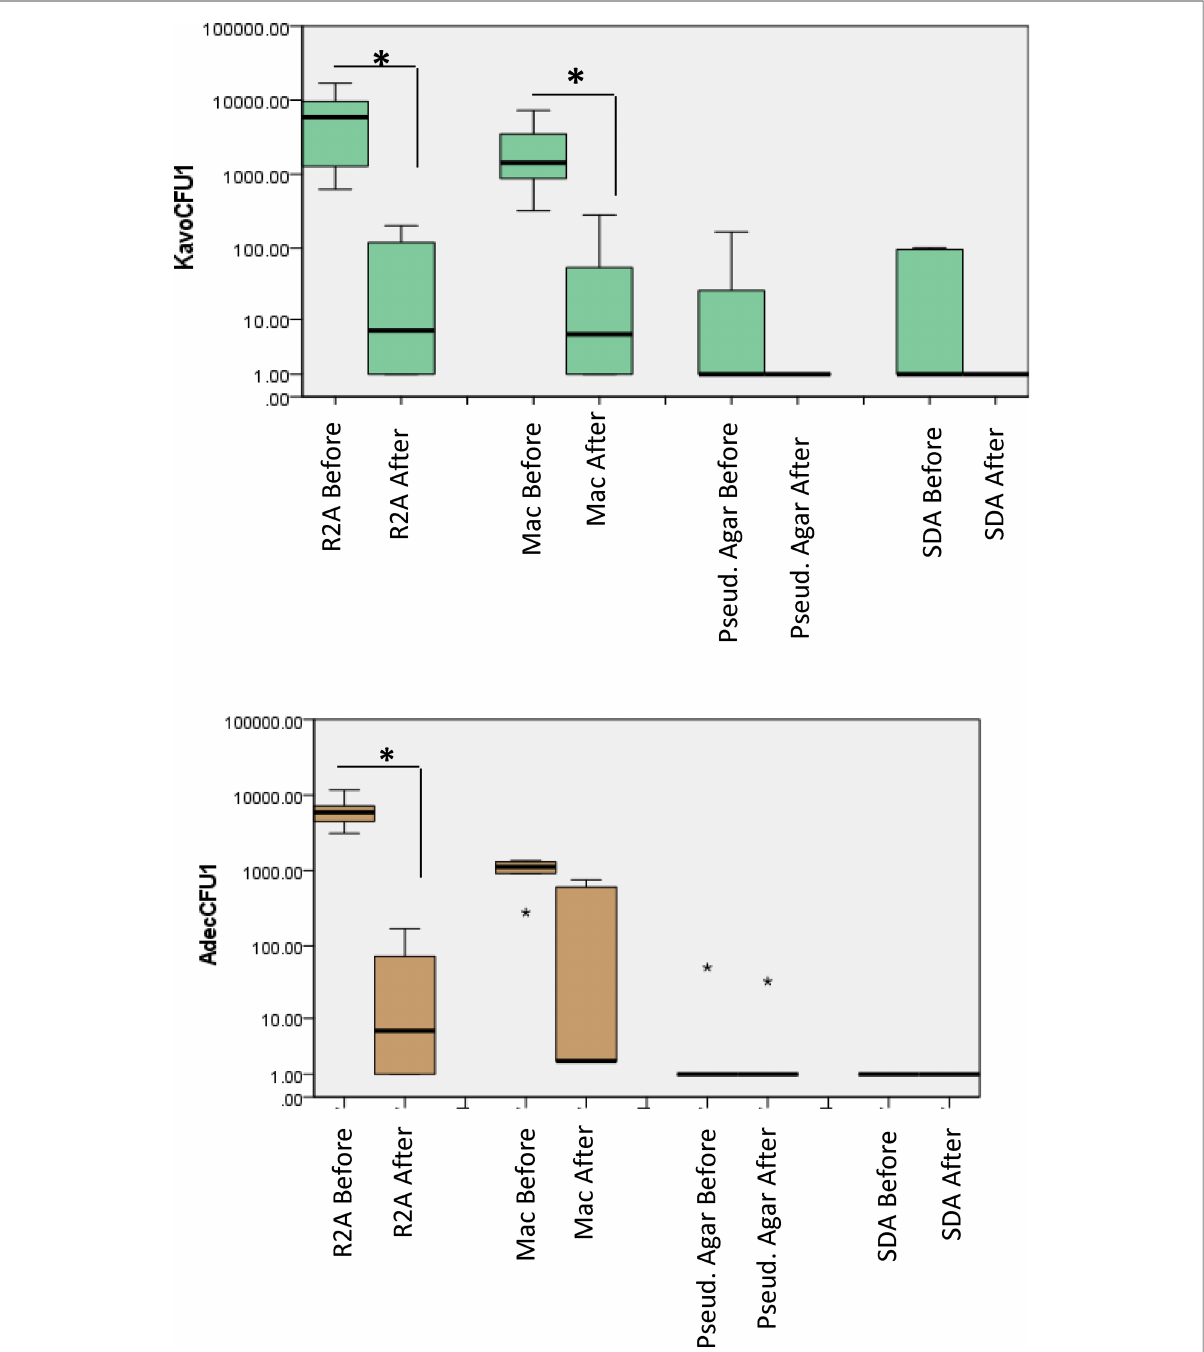
FIGURE 2 Total viable counts from water samples collected from dental unit hand pieces. Samples were collected before and after treatment, 10-fold serially diluted up to 10 − 5 and plated on different culture media. The plates were then incubated in different atmospheric conditions for different incubation times as described in “ methods ” . P <0.05 Mann Whitney